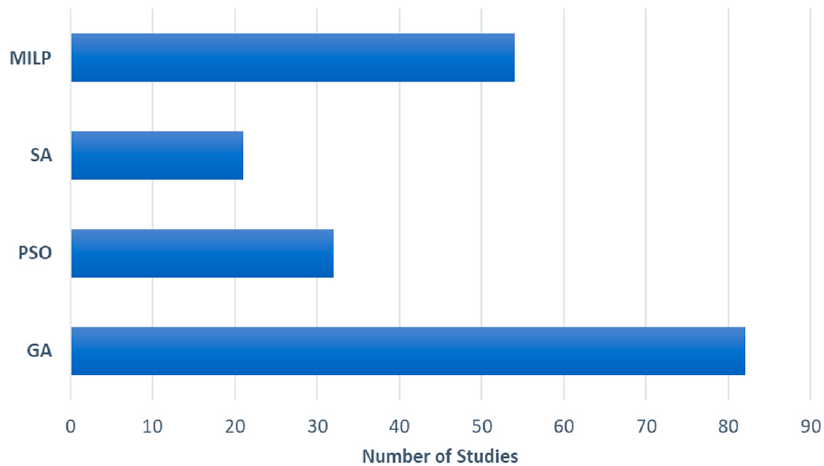
Figure 5. Statistical report of preliminary studies based on optimization techniques.